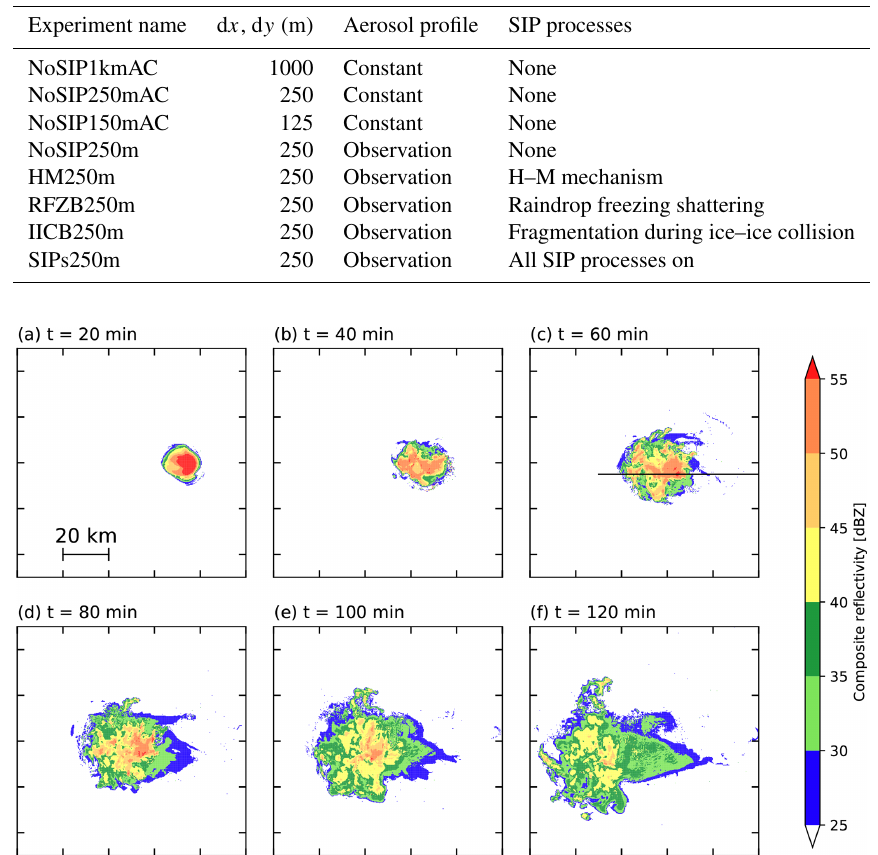
Table 1. Sensitivity experiments.